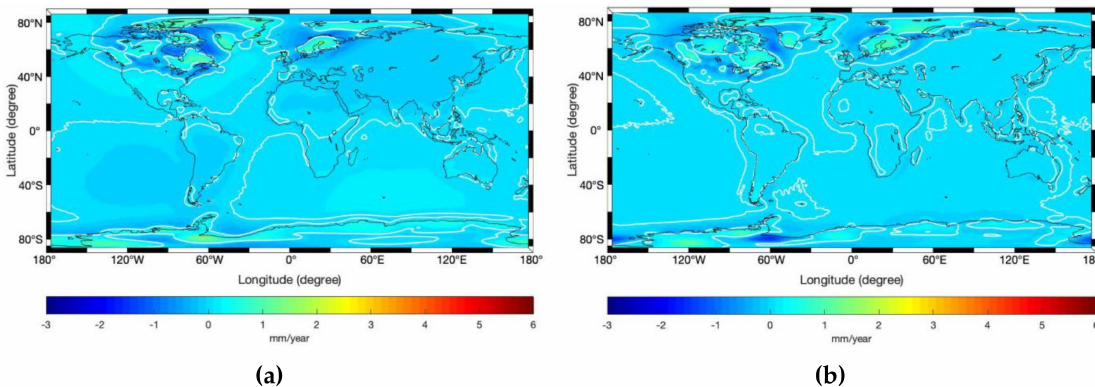
( d ) Figure 6. Differences in uplift rates of ICE6GD, PUR16, PUR18, and GPSinterp with respect to the weighted average GIA model ICE6Gavg. ( a ) Difference between ICE6GD and ICE6Gavg; ( b ) difference between PUR16 and ICE6Gavg; ( c ) difference between PUR18 and ICE6Gavg; ( d )